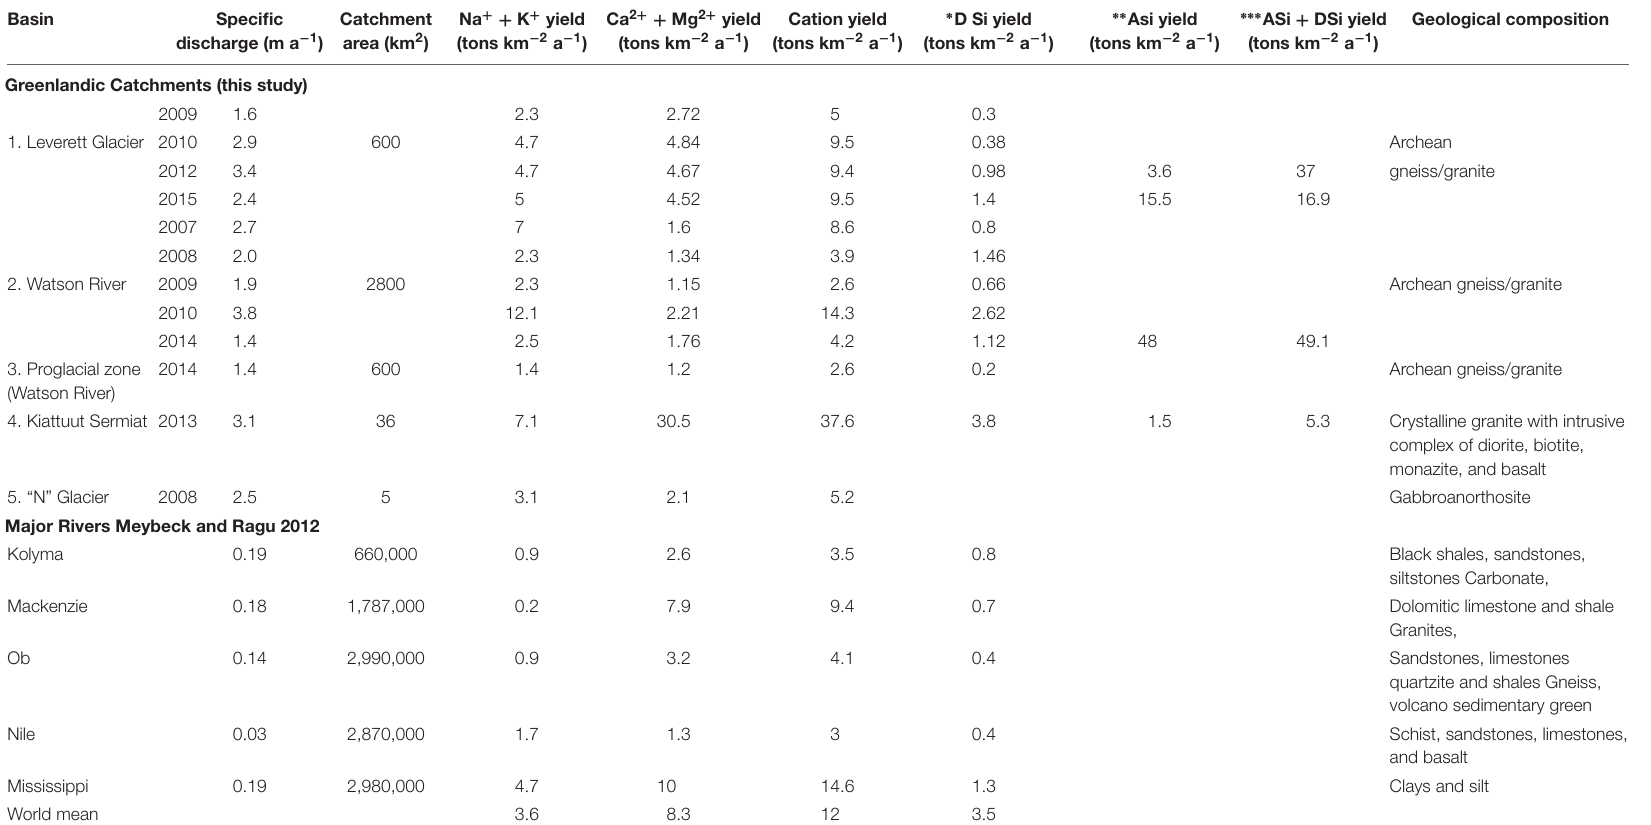
TABLE 2 | Chemical weathering fluxes summary from Greenland catchments and major rivers.